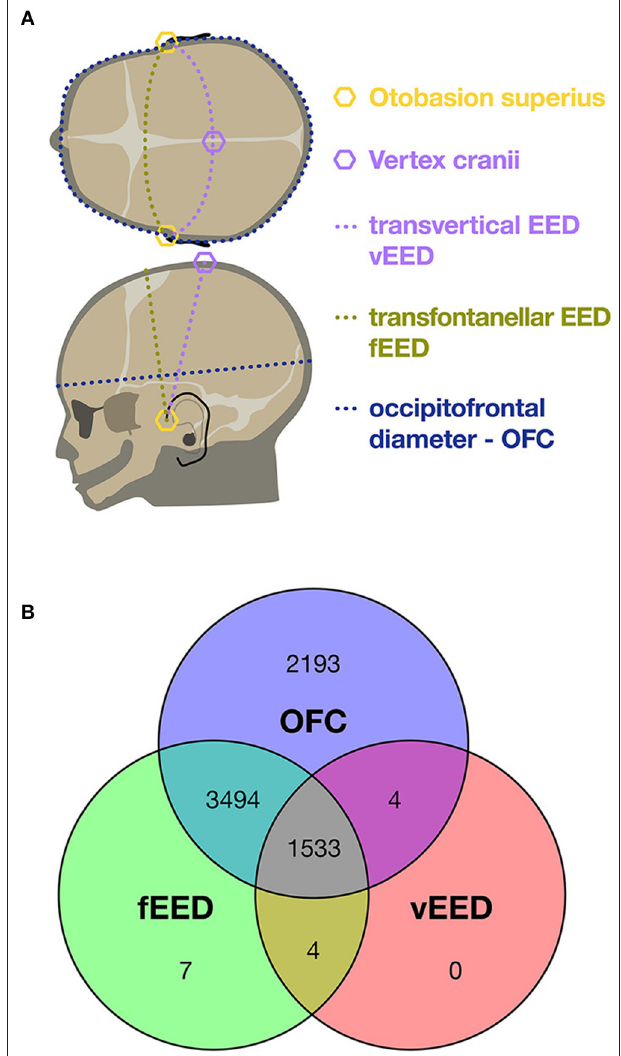
FIGURE 1 | (A) Schematic of cranial measures. (B) Venn diagram of the 13,803 head circumferences acquired from the 7,235 patients included. In 69% occipitofrontal circumference (OFC) and transfontanellar ear-to-ear distance (EED) were available, in 21% all three head circumferences. This is mostly due to the fact that transvertical ear-to-ear distances (vEED) was added to the protocol during the course of the